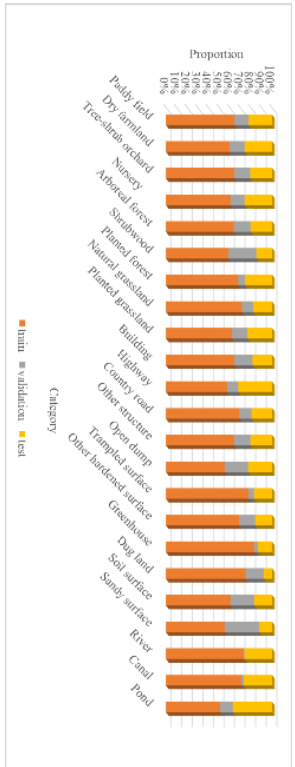
Figure 5 Distribution of training, testing, verification dataset